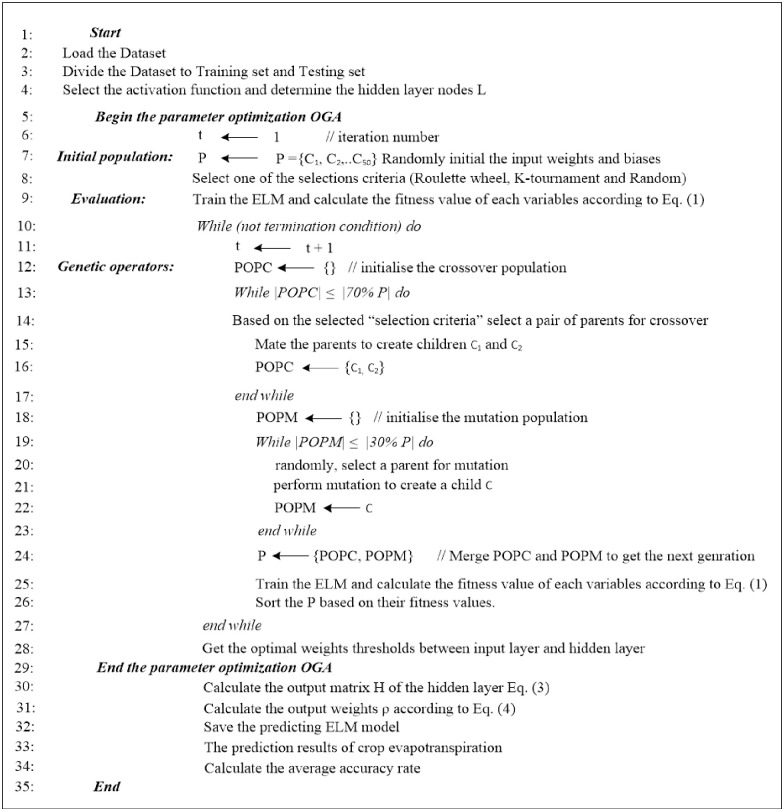
Pseudocode of the OGA-ELM [28].